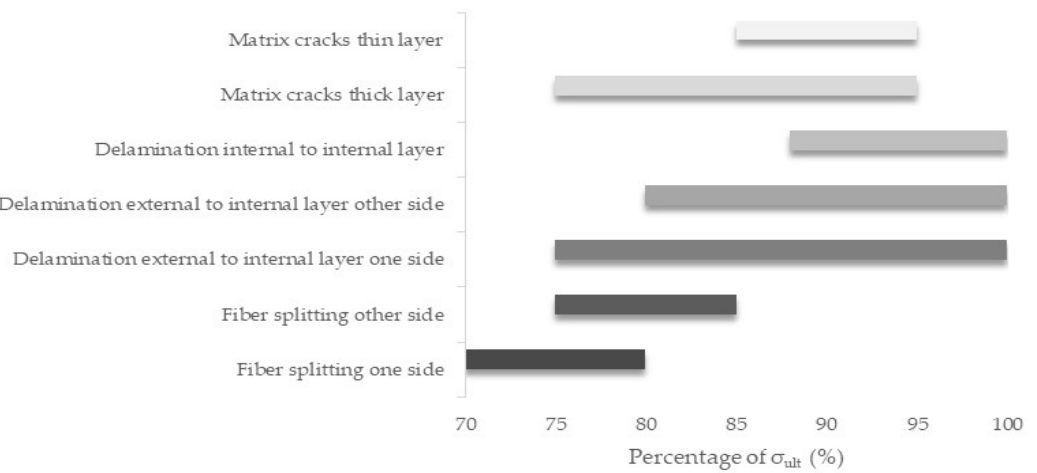
Figure 6. Damage process during the quasi-static tests for the [0°/30°] 2s laminates.